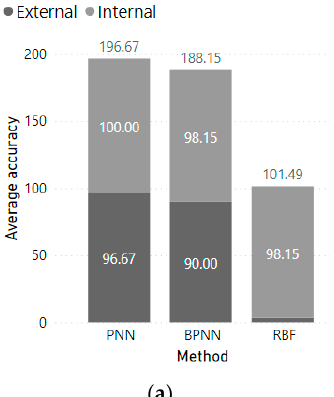
Figure 13. Comparison of the sum of detection accuracy between internal and external faults in each case: ( a ) the maximum coefficients algorithm (Case 1); ( b ) the maximum ratio algorithm (Case 2).